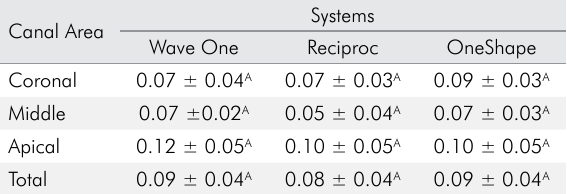
Table 2. Means (SD) of transportation in different canal